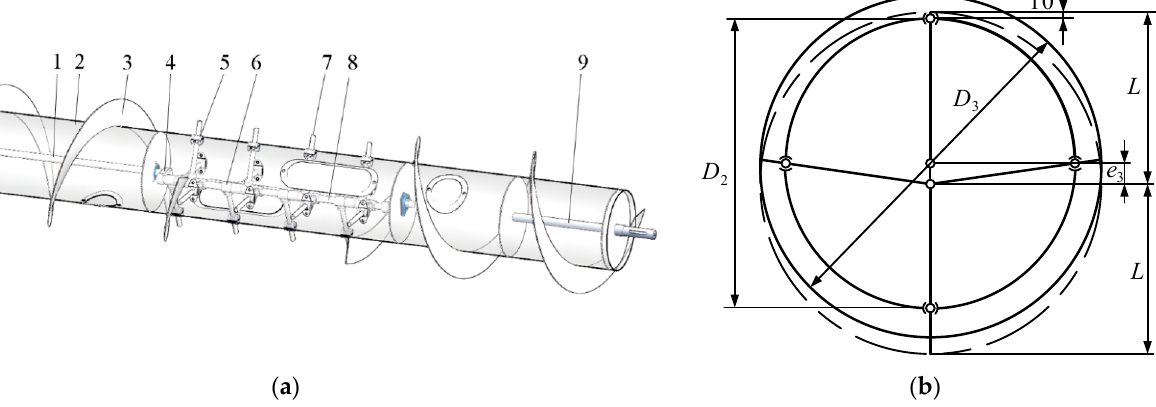
Figure 7. Structural diagram of a screw conveyor. ( a ) Overall structure; ( b ) Schematic diagram of retractable fingers. 1. Fixed central axis; 2. Screw cylinder; 3. Spiral blade; 4. Crank; 5. Sleeve; 6. Finger seat; 7. Finger; 8. Finger shaft; 9. Conveyor driving shaft.